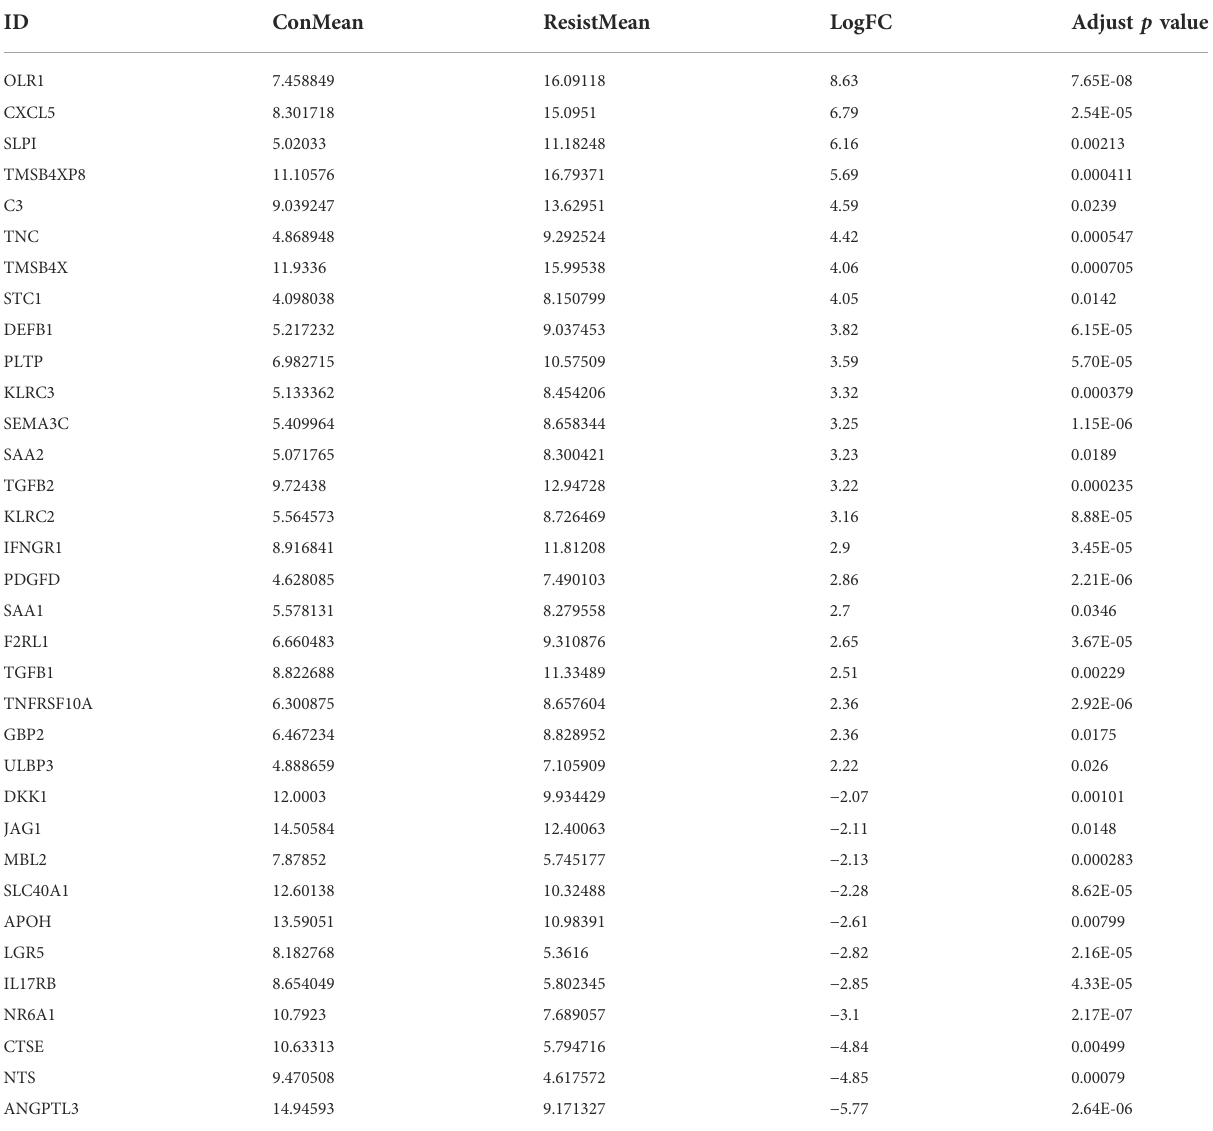
TABLE 1 DEIRGs in sorafenib-resistant HCC